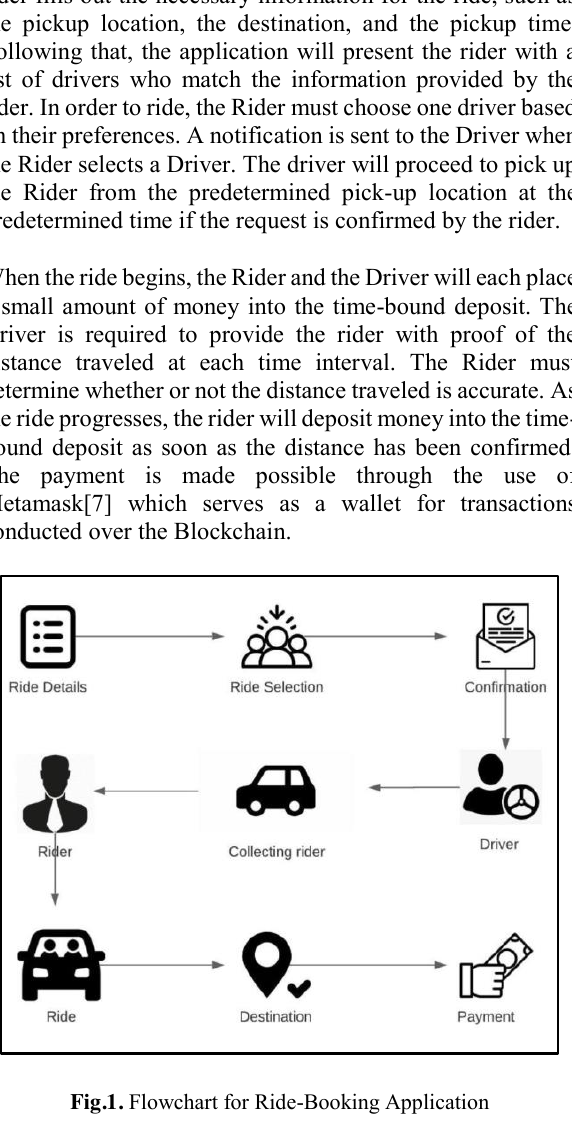
Fig.1. Flowchart for Ride-Booking